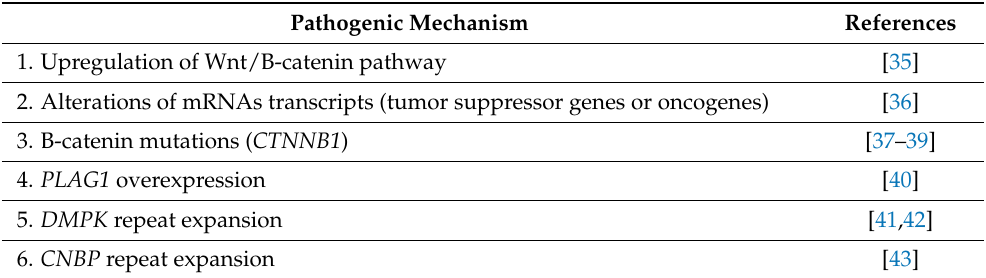
Table 3. Postulated pathogenic mechanisms underlying DM